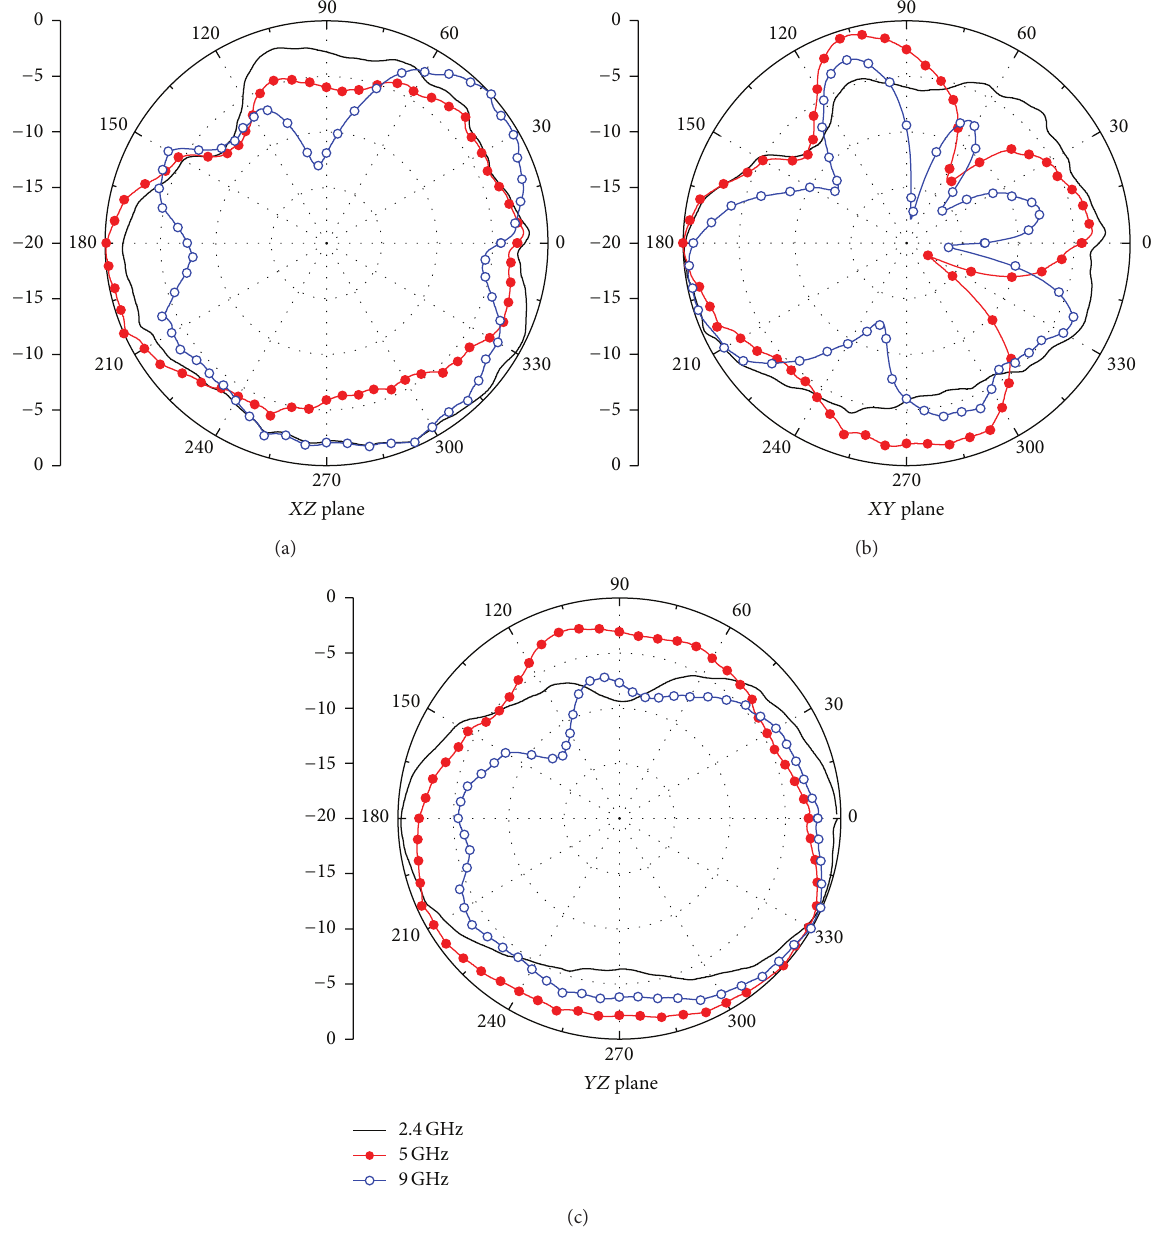
Figure 7: Radiation patterns of the proposed